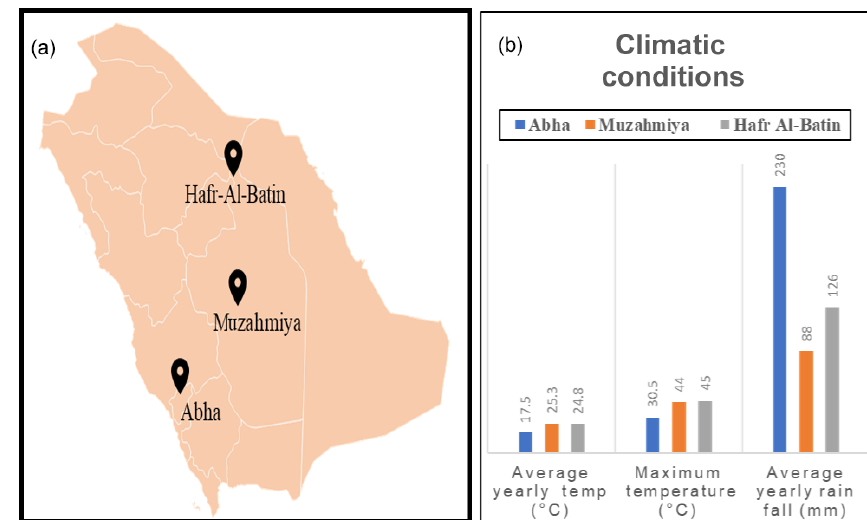
Figure 1. Location of sampling sites (a) and the climatic conditions at these sampling sites (b)